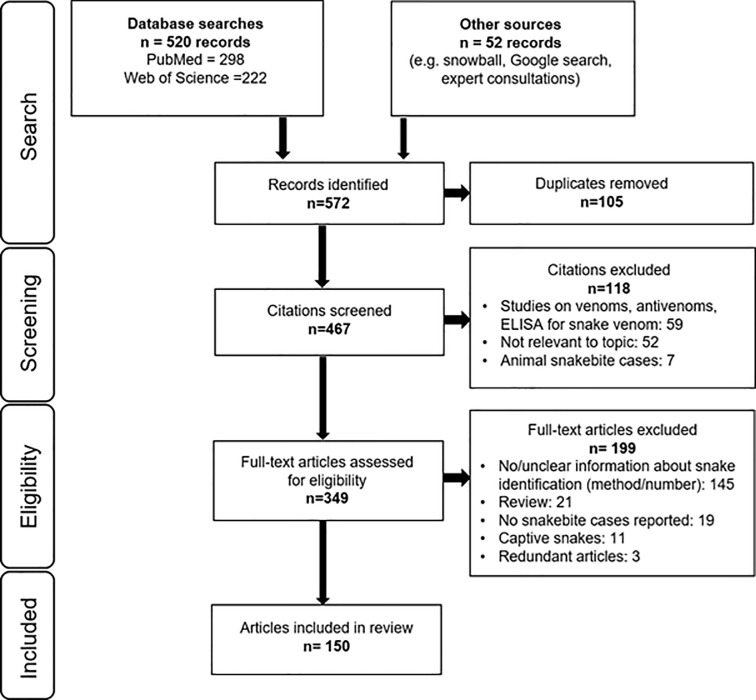
PRISMA flow diagram.